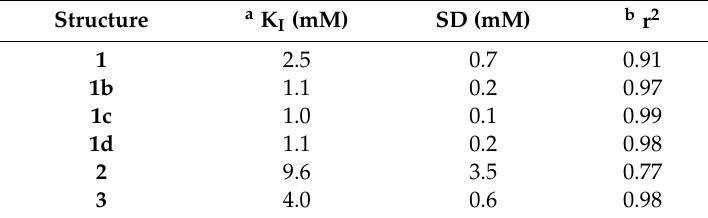
Table 2. A ffi nities determined by competitive 19 F-R 2 filtered NMR